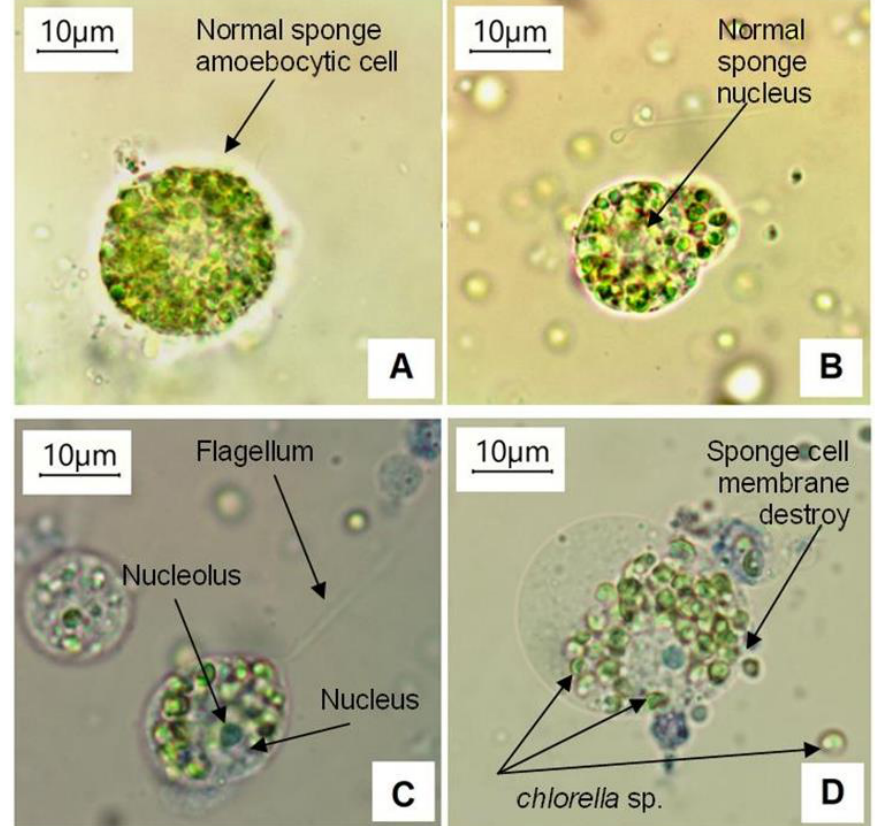
Figure 3. Lubomirskia baikalensis cells. ( A ) – normal SA1- cell of 21.7 μm size; ( B ) – normal SA1-cell of 16.1 μm size; ( C ) – swelling of SA4-cell with flagellum; a cell stained with methylene blue; ( D ) – SA1- cell of 27.8 × 23.9 μm size swelled and lysed due to linear alkybenzene sulfonate 72 h exposure (20 μg L −1 ); the cell stained with methylene blue; symbionts Chlorella sp. moving out of the host cell.